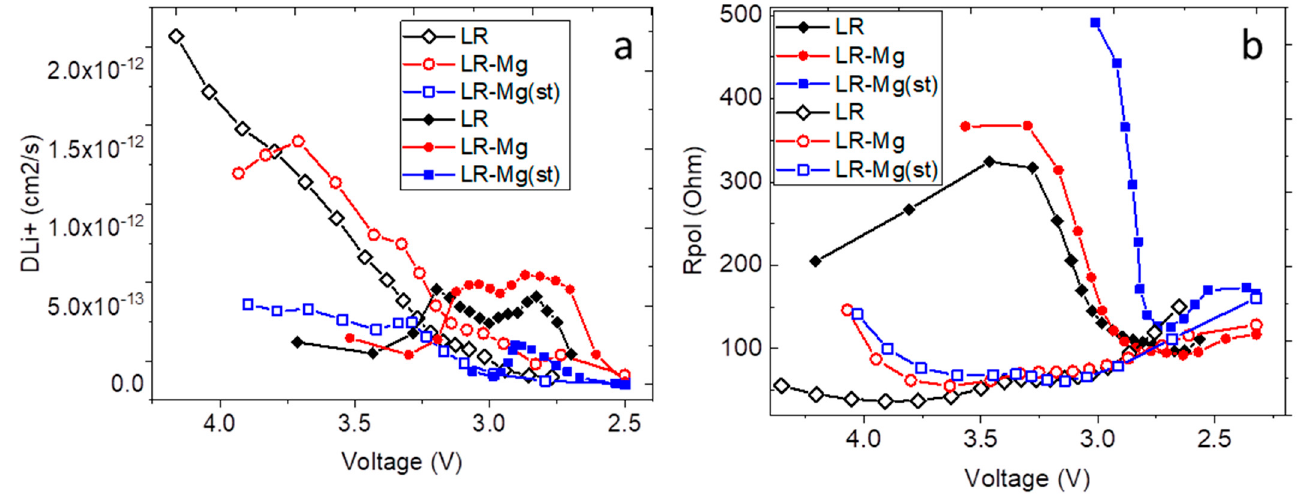
Figure 7. Variation of ( a ) D Li+ and ( b ) R pol as a function of cell voltage for different cycles determined by GITT. Open and solid symbols designate the data derived from 11-th and 77-th cycles, respectively. Sample names are shown in the figures.